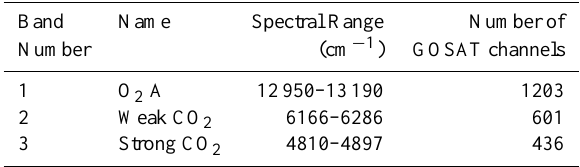
Table 1. NIR spectral bands used in the ACOS retrieval.